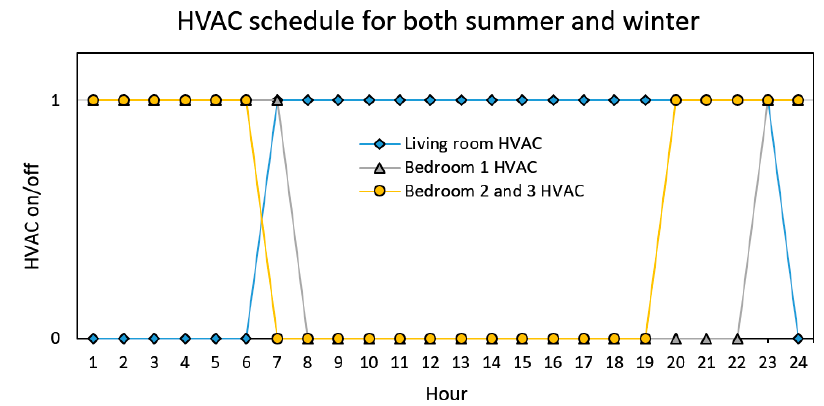
Figure 26. The HVAC schedule for each room.